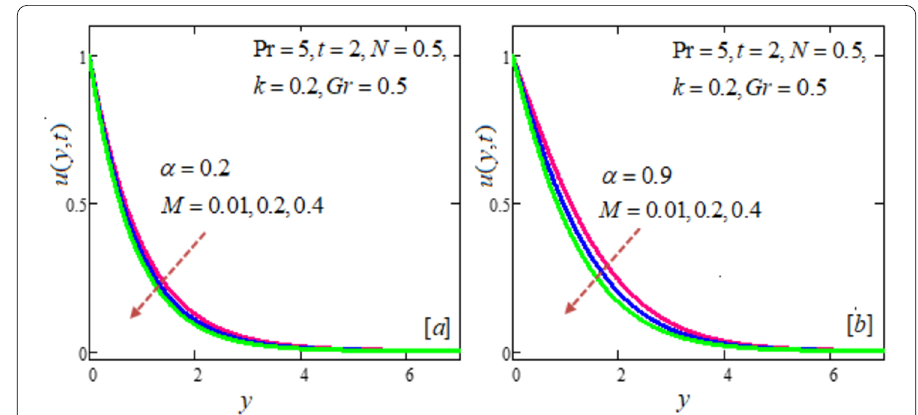
Figure 7 Velocity profile variation with magnetic parameter M and fractional parameter α